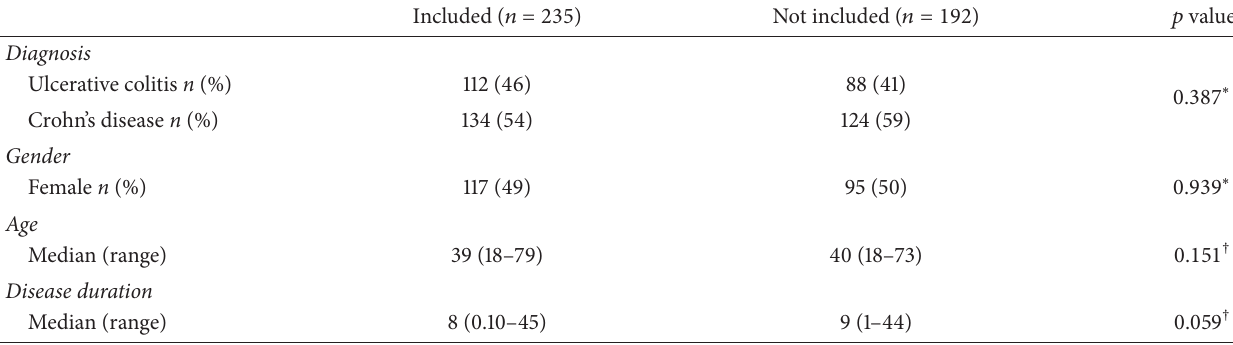
Table 1: Diagnosis, demographic, and clinical data for those included compared to those not included.